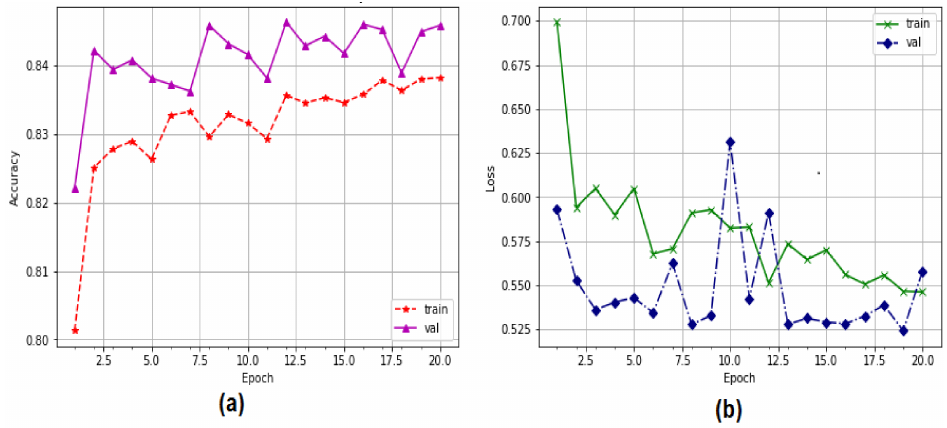
Figure 9. Performance of CNN model using multi-classification: ( a ) accuracy, ( b ) loss.